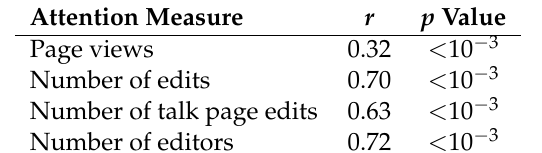
Table B.1. Correlation of eigenvector centrality with behavioral measures of attention.